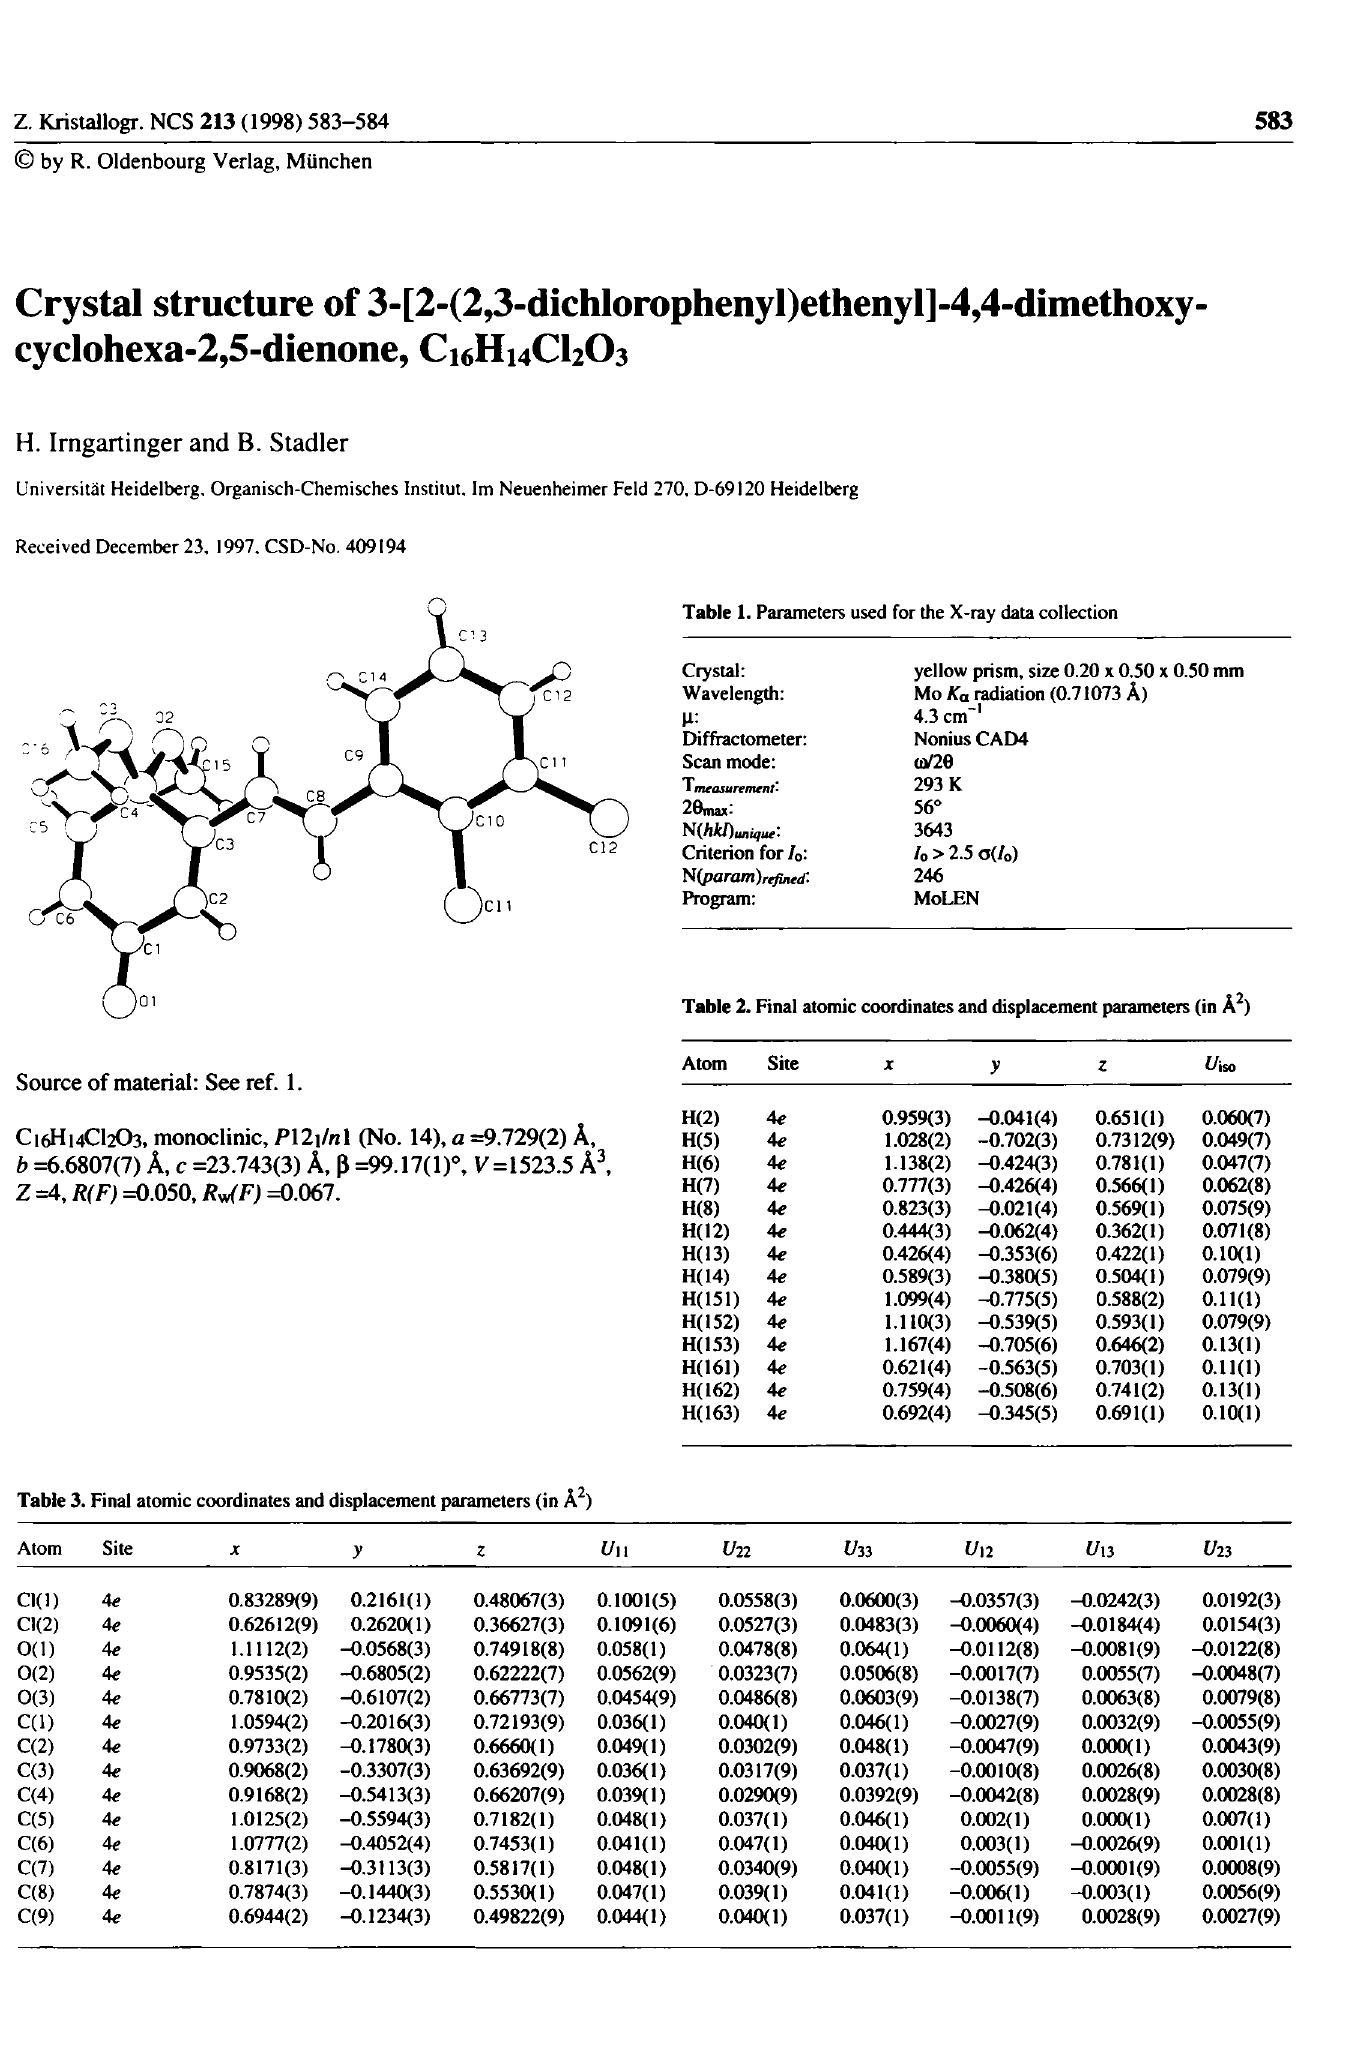
Table 3. Final atomic coordinates and displacement parameters (in Â^) Atom